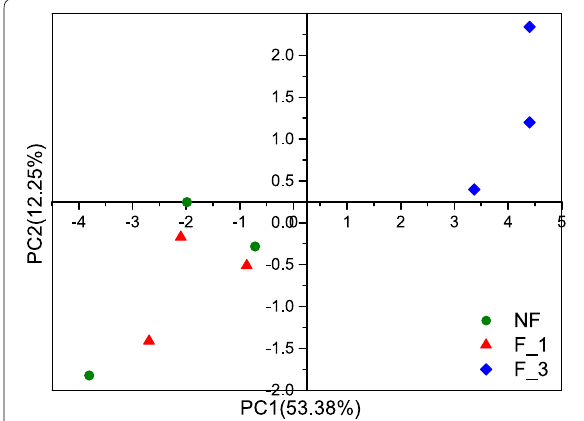
Fig. 8 Principal component analysis (PCA) of carbon utilization of the soil microbial community (72 h). NF non-fumigation, F_1 chloropicrin- fumigation for 1 year, F_3 continuous chloropicrin-fumigation for 3